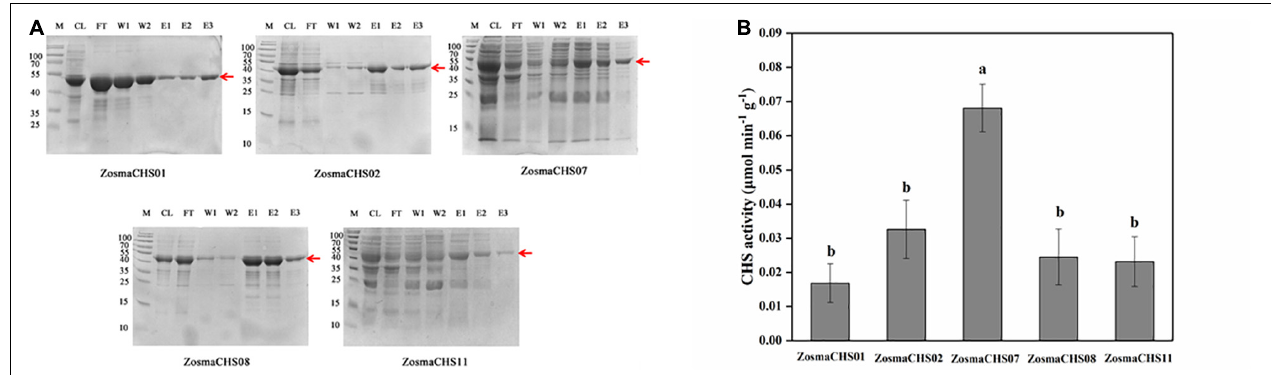
FIGURE 5 | The validation of CHSs in Z. marina . (A) Prokaryotic purification of the five ZosmaCHS proteins. The corresponding protein bands were pointed out by the red arrow at the expected position (around 43 kDa). CL: cell with lysis buffer; FT: flow through buffer; W1: primary washing buffer; W2: secondary washing buffer; E1: primary elution buffer; E2: secondary elution buffer; E3: third time elution buffer. (B) Enzyme activity of ZosmaCHS01, 02, 07, 08, and 11. Different letters indicate significant differences ( P < 0.05, One-way